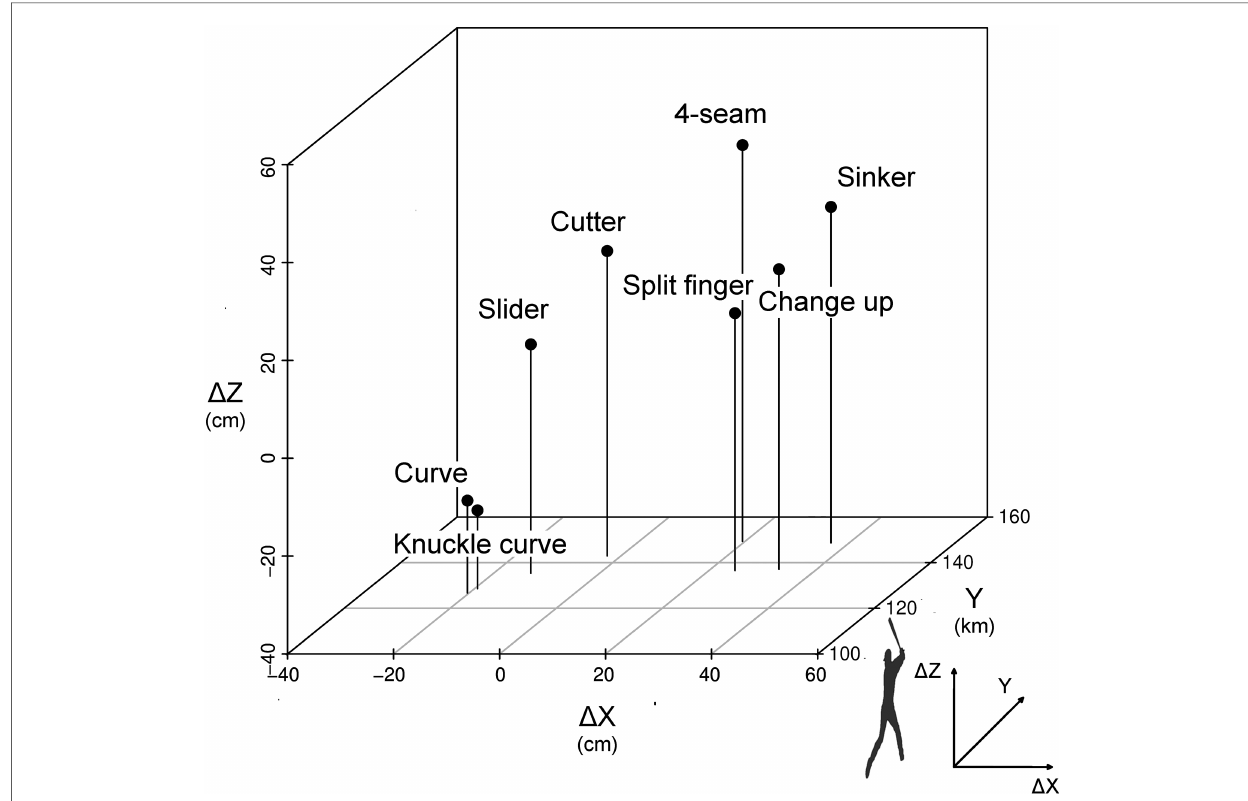
FIGURE 3 3D coordinates of Δ X and Δ Z and release speed. Δ X, release speed, and Δ Z are shown in X, Y, and Z axes, respectively. The distance between 4-seam and each type of pitch is as follows: sinker, M=21.33 cm; slider, M=47.57 cm; changeup, M=24.23 cm; cutter, M=29.29 cm; curve, M=74.23 cm; split fi nger, M=29.41 cm; and knuckle curve, M=76.23